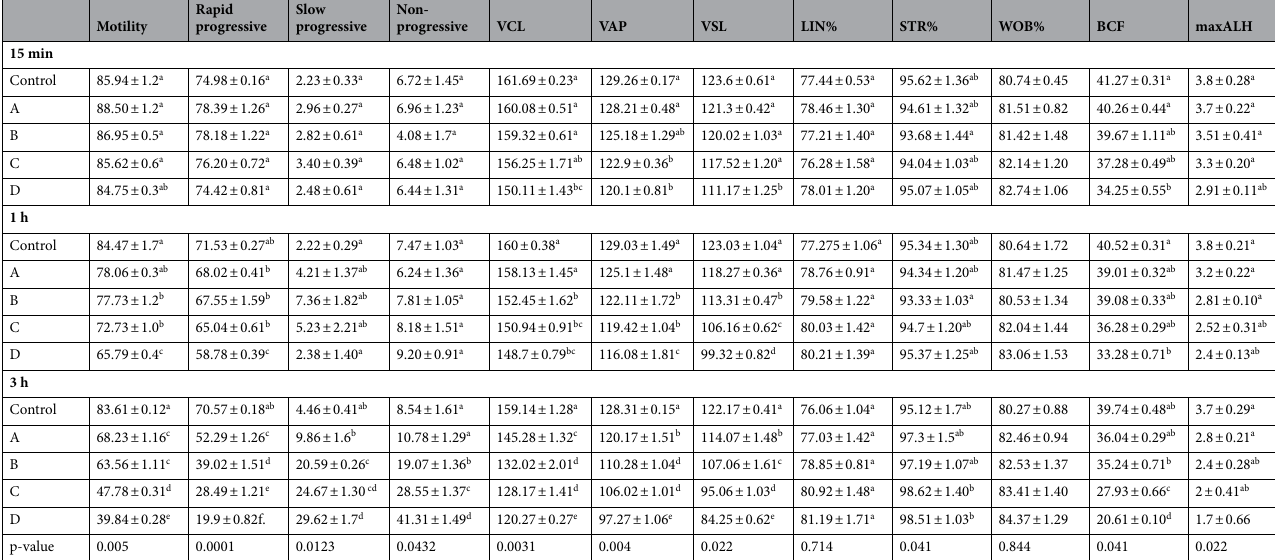
Table 3. Effect of in-vitro exposure of spermatozoa to different concentrations of mercuric chloride (0.031–1.25 µg/ml) on motile spermatozoa count at different time intervals. Data presented are mean ± SE of the semen samples of six bucks. VCL curvilinear velocity (µm s −1 ), VSL straight-line velocity (µm s −1 ), VAP average path velocity (µm s −1 ), LIN linearity of forward progression (%), STR straightness (%), WOB wobble (%), maxALH maximum amplitude of lateral head displacement (µm), BCF beat-cross frequency (Hz). A = 0.031 µg/ml, B = 0.125 µg/ml, C = 0.25 µg/ml, and D = 1.25 µg/ml HgCl 2 . Different small superscripts in the columns indicate significant (p < 0.05) differences in kinematic patterns between control and different treatment groups at different time intervals.